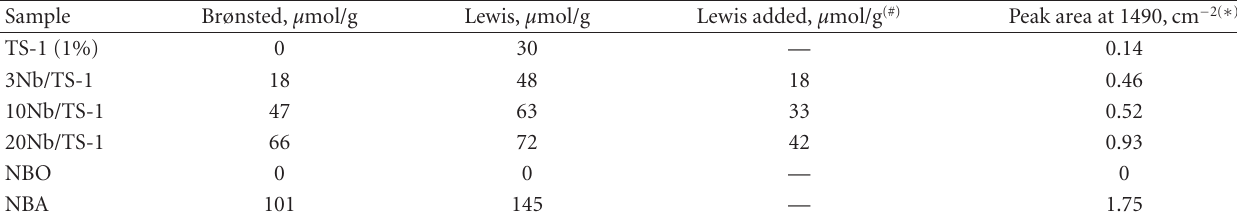
Table 3: The amount of the Brønsted and Lewis acid sites and the area under the peak at around 1490 cm − 1 of the samples. Sample